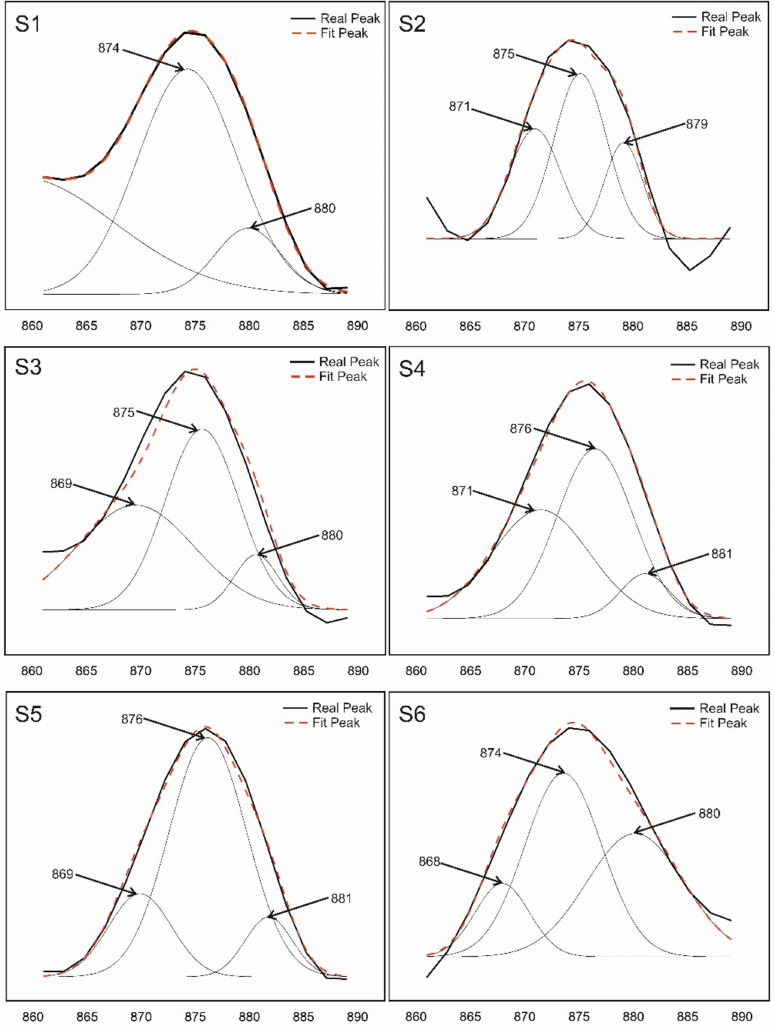
Figure 4. Deconvolution region at 800–920 cm − 1 for carbonate groups of the Ti-HA composites